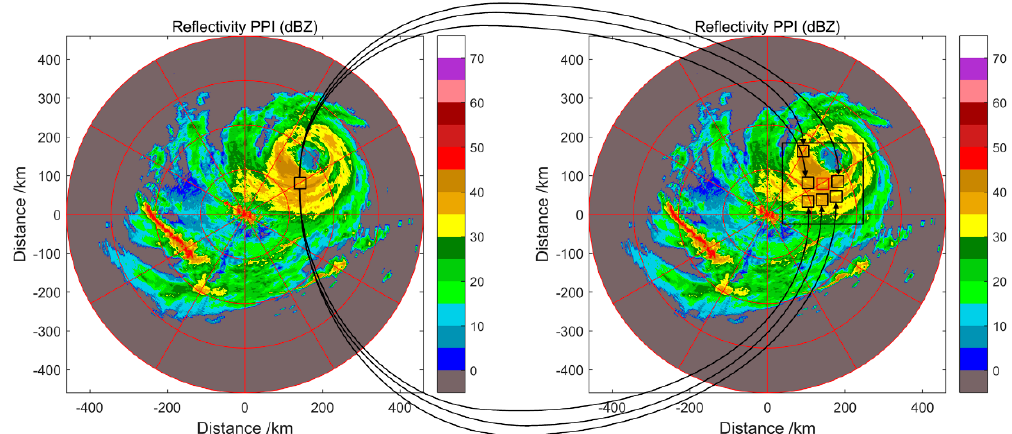
Figure 4. An example of searching for the nonlocal similar patches to the given radar echo patch. The black square in the left Plan Position Indicator (PPI) represents the given patch which needs to search the nonlocal similar patches. The big square in the right PPI represents the search window, the red square represents the given patch, and the other squares in the right PPI represent the similar patches to the given patch using the moving window model within the search window. The tested data is the first elevation cut of the CINRAD SA radar on 23 September 2008 at 20:13 (BJT), which has 360 radials in an elevation cut. Each radial has 460 range bins.